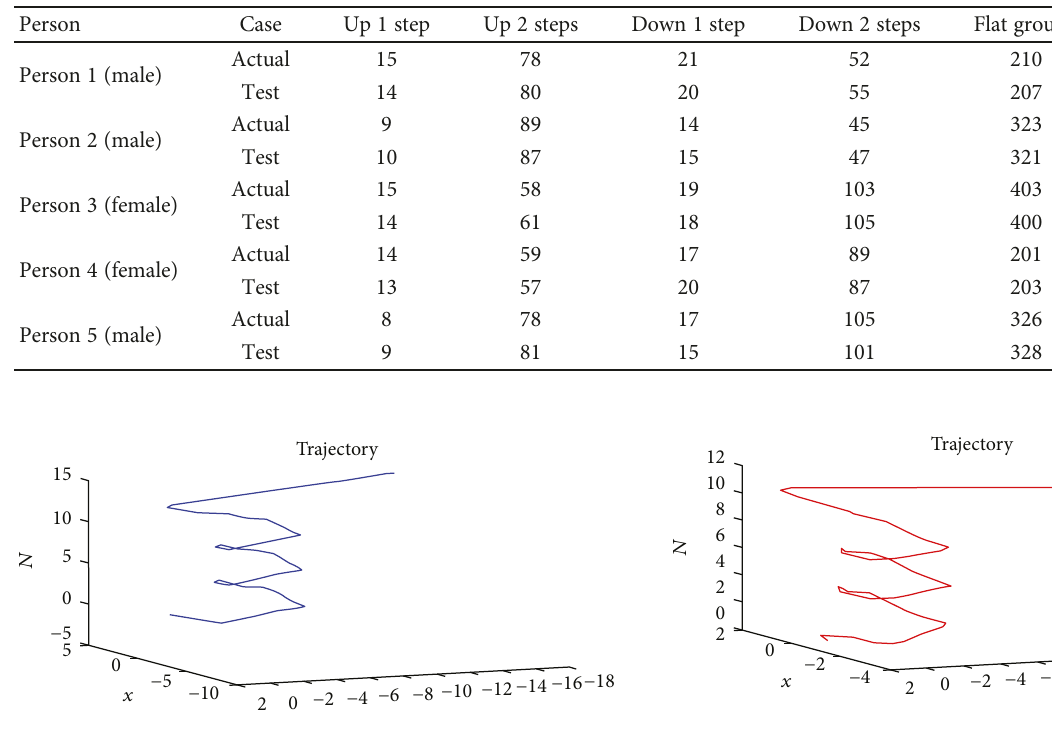
Figure 10: Using only SINS 3D indoor positioning results. Figure 11: 3D positioning results of the proposed linear gait discriminant